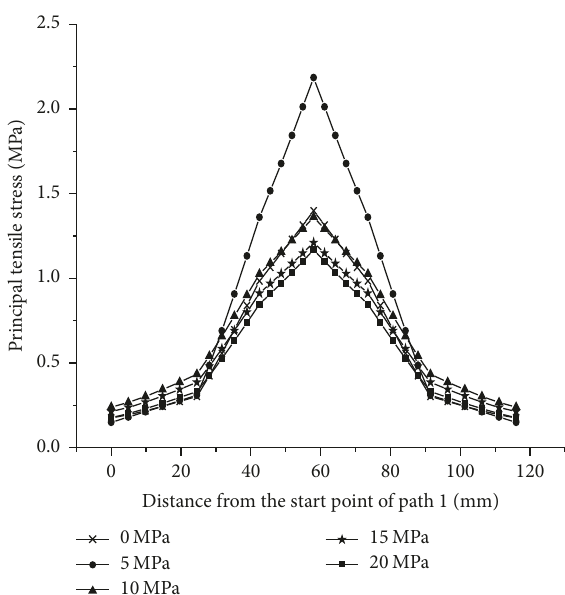
Figure 19: Comparison of the principal tensile stress generated along path 1 from corrosion-induced expansion when the dis- placement resulting from corrosion-induced expansion reaches 0.005 mm.